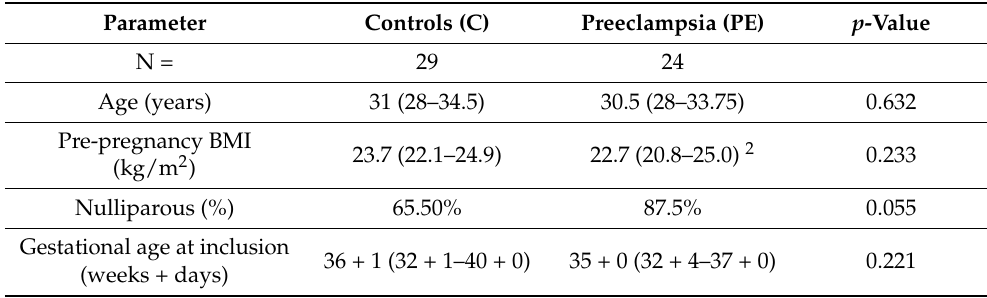
Table 1. Patient demographics, questionnaire answers (smoking, diet, and probiotic food consump- tion), and OGTT results for singleton pregnancies included in the present study 1